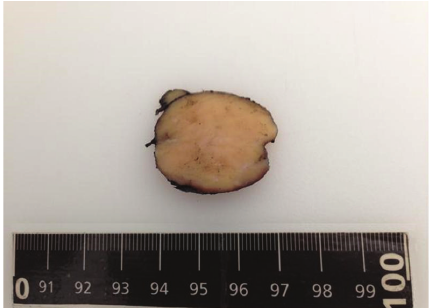
Figure 1: Solid, well-circumscribed tumor measuring 5 × 3.5 × 2.5 cm in size.